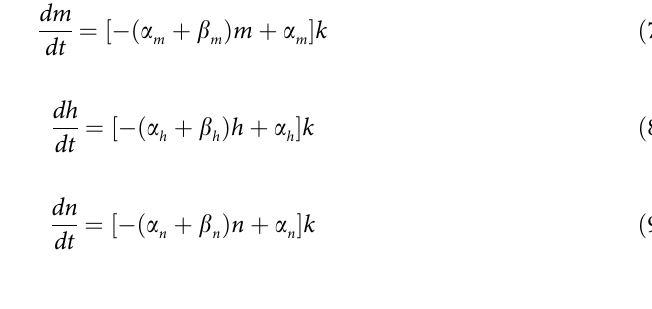
For comparisons with the measurements of Verveen, we also used the CRRSS dynamics at 37˚C to model the nodes of Ranvier, for details see Table 1 and [12, 16, 31]. We used 201 and 101 compartments for non-myelinated and myelinated axons, respectively and placed the elec- trode above the center of the axon. The system of ordinary differential equations was com- puted in C++ using the backward Euler method with time steps of 2.5 μ s. Cathodic 0.1ms pulses were used for all simulations. The HH model describes the ion current densities in μ A/cm 2 as sum of sodium, potassium and leakage currents: where the gating probabilities m, n, h are defined by voltage dependent channel opening rates α and closing rates β (see Table 1 for details)